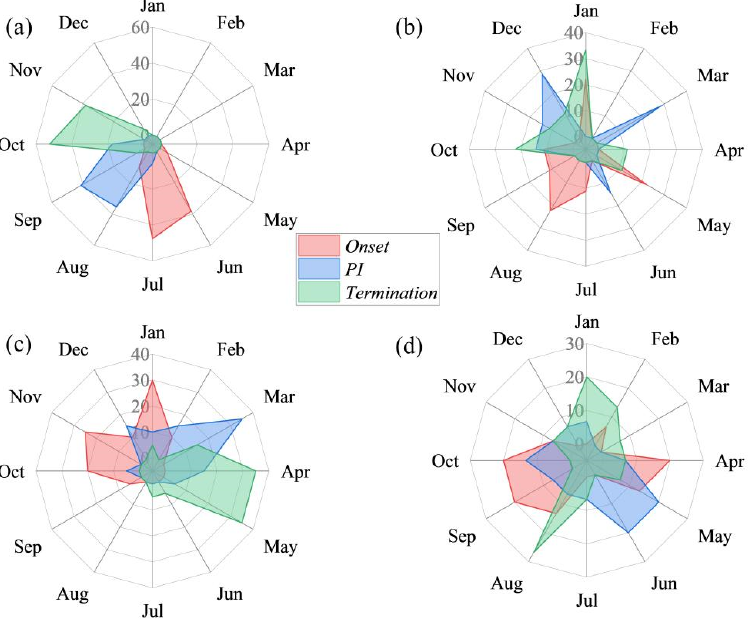
Figure 6. The onset, peak intensity ( PI ), and termination time of hydrological drought ( HD ) events within a year based on the fixed drought threshold ( FDT ) ( a , c ) and variable drought threshold ( VDT ) ( b , d ) at the HP0 station of the Harp Lake catchment ( a , b ) and Lantang station of the Dongjiang River catchment ( c , d ).